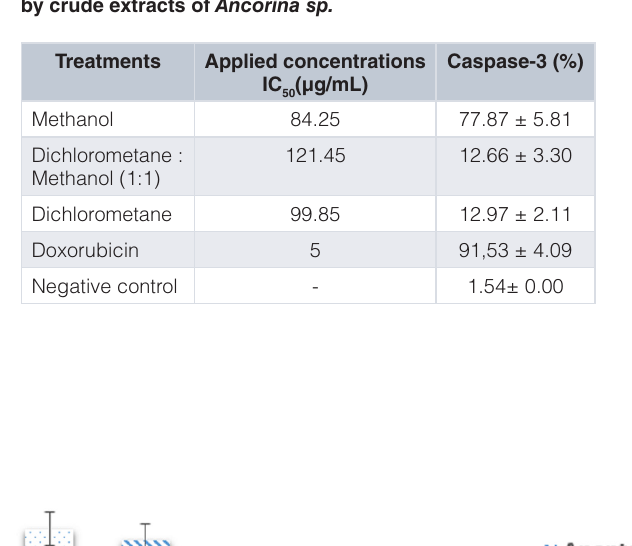
Table 3. Percentage of caspase-3 activation after treatment by crude extracts of Ancorina